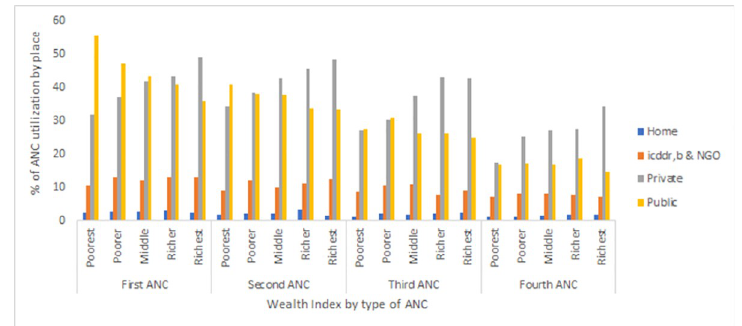
Fig 5. Health facility utilization for ANC visits by wealth